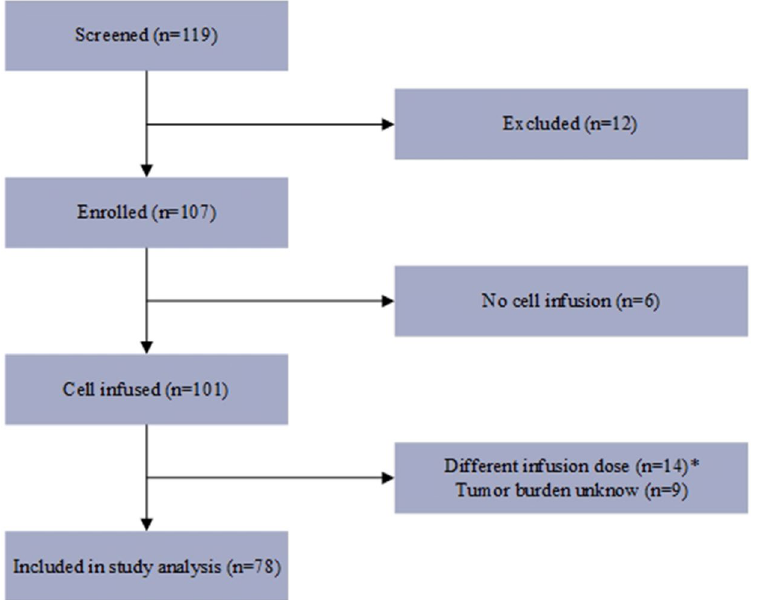
Figure 1. Flow chart of the study participants. The diagram shows the courses all of the study participants from the time of consent to treatment. *In this study, only patients with an infusion dose of 5 × 10 6 cells/kg were included in the statistical analysis.